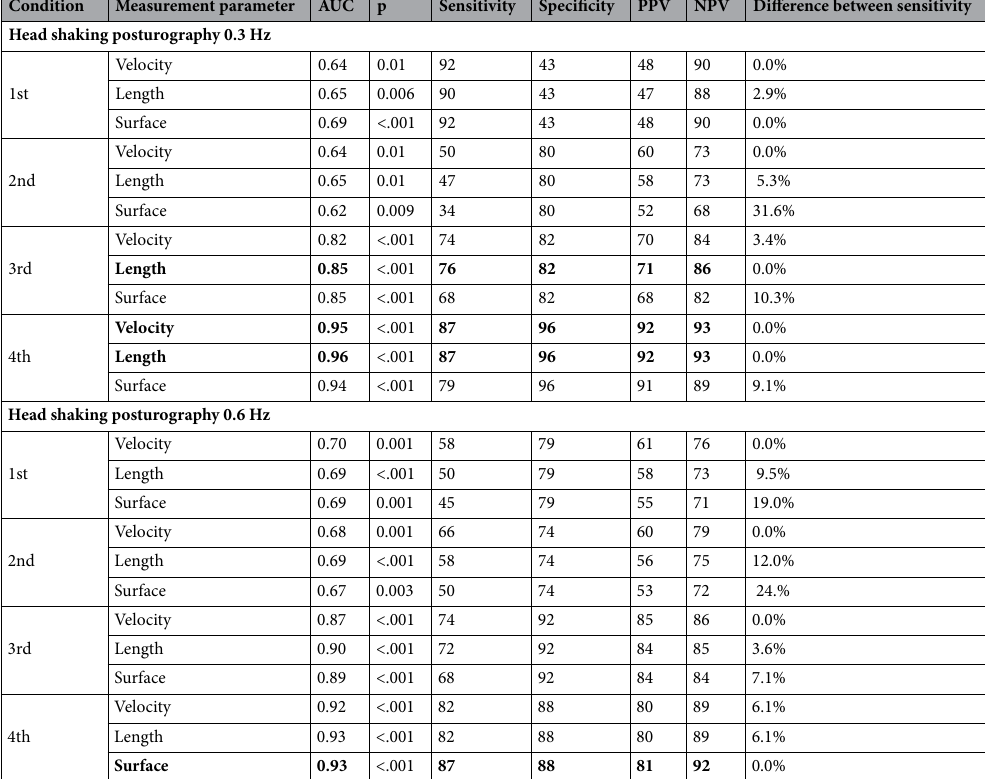
Table 2. The sensitivity and specificity of MediPost according to the measuring parameters. For comparison purposes the results of specificity for length and surface were adjusted to the value obtained for sway velocity. Conditions: 1st (eyes open/stable surface), 2nd (eyes closed/stable surface), 3rd (eyes open/foam), 4th (eyes closed/foam). The most significant results are in bold. AUC area under curve, PPV positive predictive value, NPV negative predictive